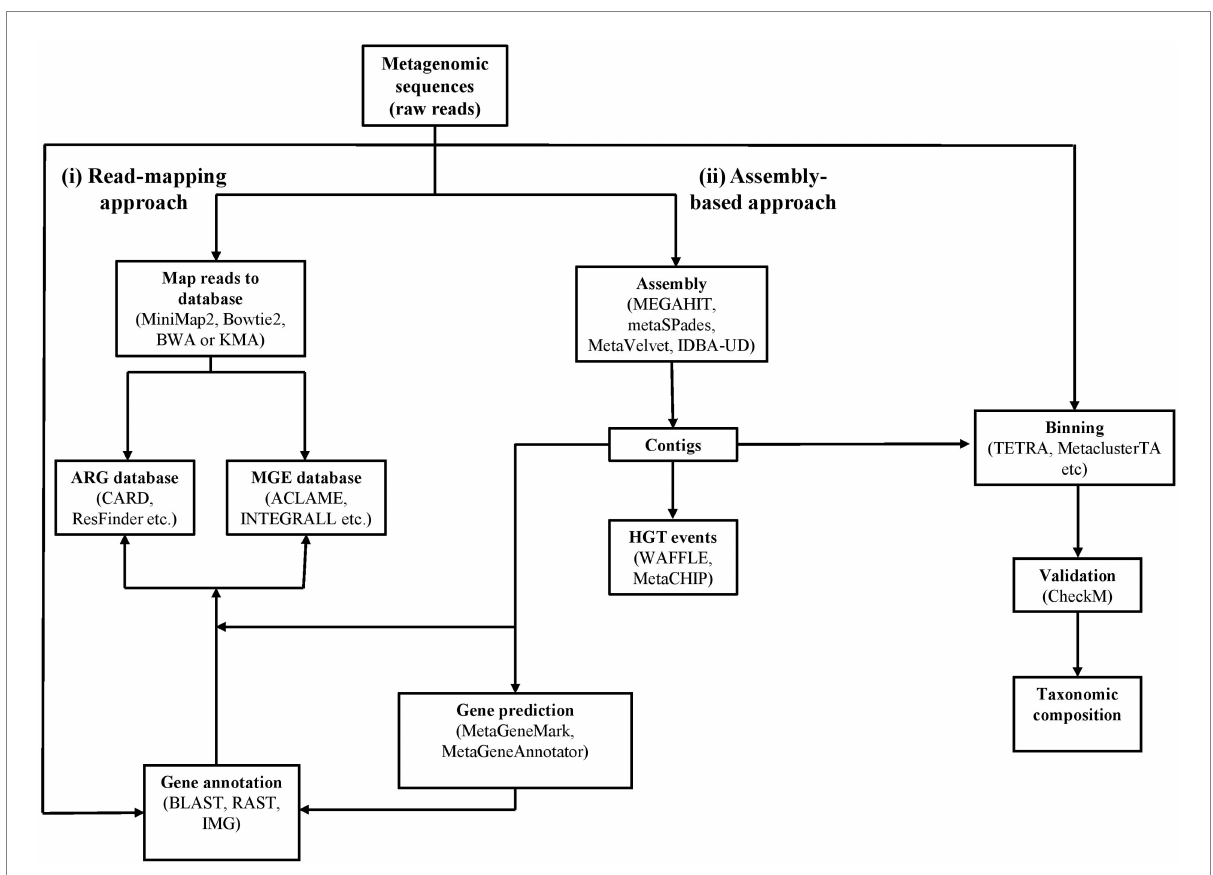
FIGURE 2 Workflow for determining antibiotic resistance genes, mobile genetic elements, horizontal gene transfer events and taxonomic composition using metagenomic data. The workflow is indicated by solid lines with example tools and databases annotated in the boxes. The complete lists are described in Tables 3,